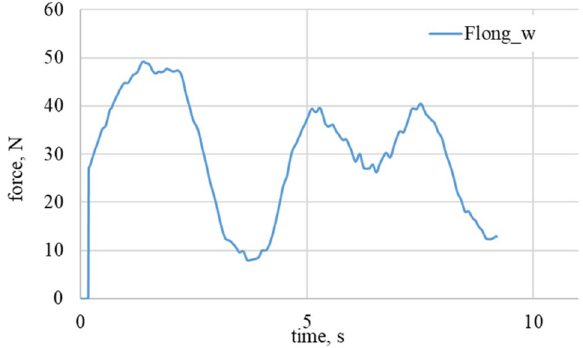
Figure 4. Longitudinal and lateral forces related to the wheel geometry for α w = 0° for granite